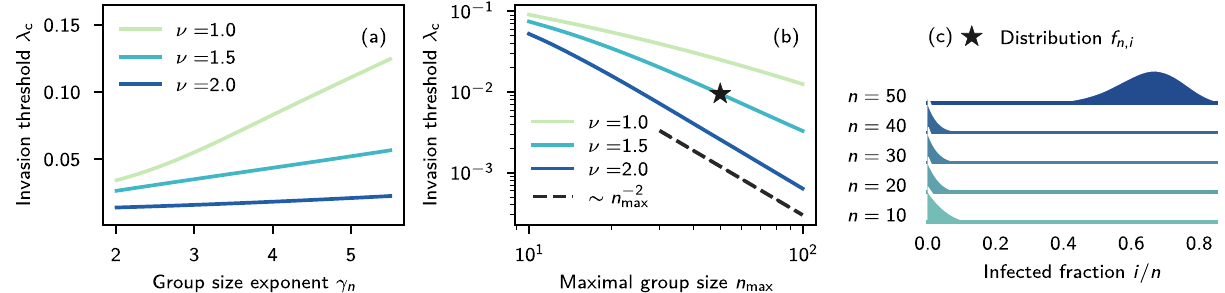
Fig. 7 Impact of heterogeneous group sizes on the invasion threshold. We considered hypergraphs with power-law group size distributions p n (cid:5) n (cid:2) γ n with various exponents γ n , a regular membership distribution g m = δ m ,4 , and various exponents ν for the infection function in Eq. (1). We obtain the invasion threshold using Eq. (15). Lower values of γ n imply a more heterogeneous group size distribution. a For a fi xed n max ¼ 20, the invasion threshold increases with larger γ n , but the effect is more limited for larger ν . b For a fi xed γ n = 3, the invasion threshold decreases like n (cid:2) ν mesoscopic localization 49,50 . c Stationary distribution f n , i for the starred case in b , i.e., γ n = 3 and ν = 1.5, with λ = 1.1 λ c , illustrating localization in the largest groups.